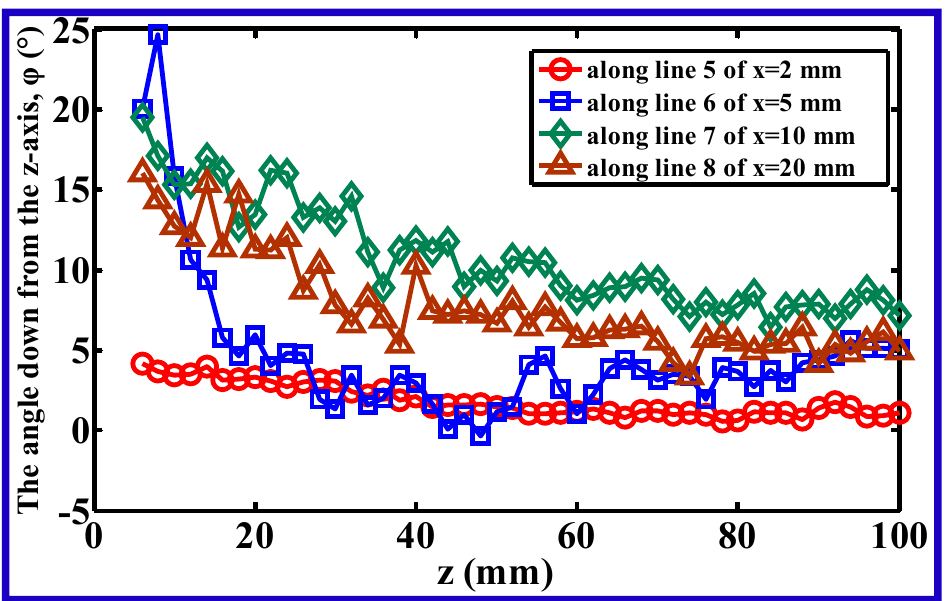
Figure 7. The angle down from the z -axis of the resultant air velocity in the x–z plane at different positions along lines 5–8.